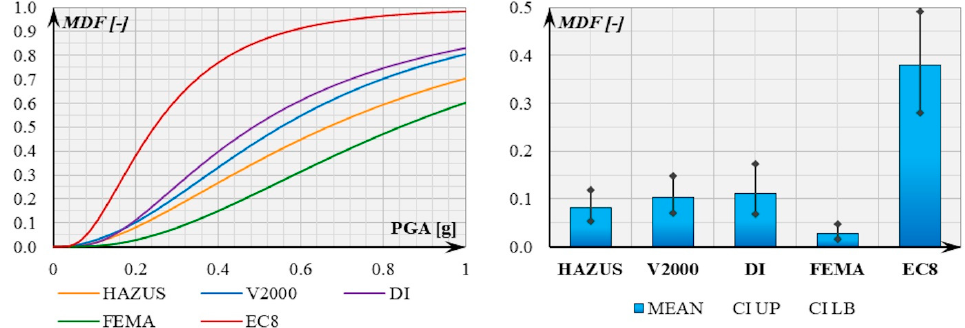
Figure 24. Vulnerability curves for each damage assessment method ( left ) and their mean damage factor values for PGA = 0.2 g ( right